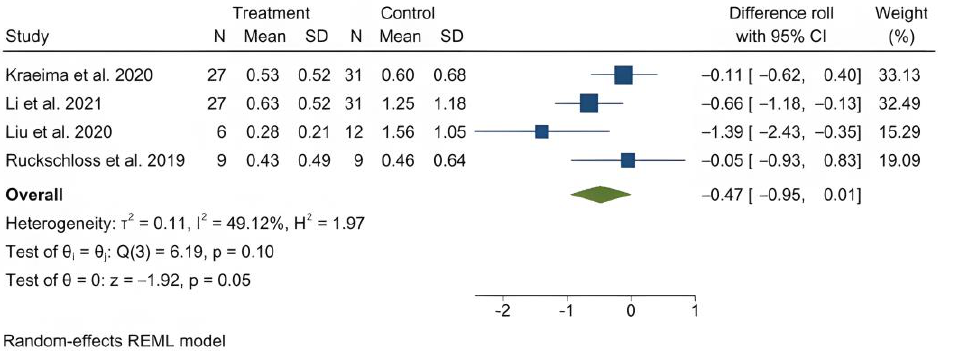
Figure 13. Forest plot showing differences in roll deviation between PSI and control (conventional osteosynthesis and CAD/CAM splint or wafer).